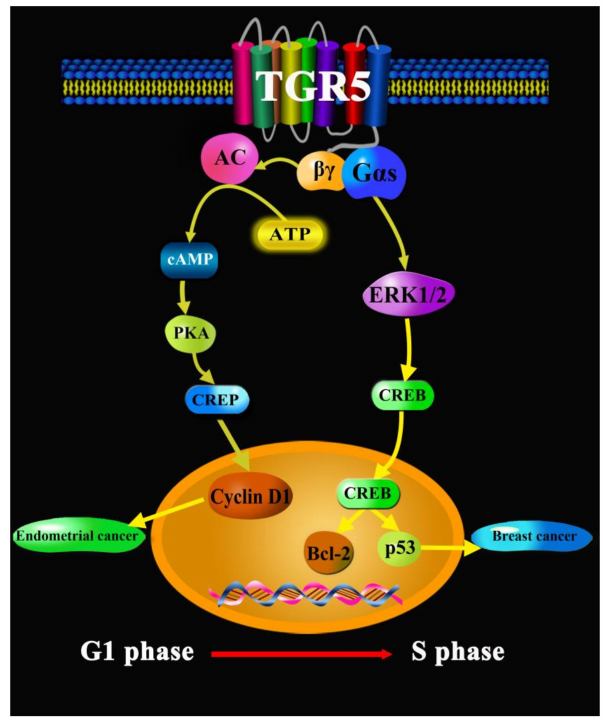
Figure 7. TGR5 in other